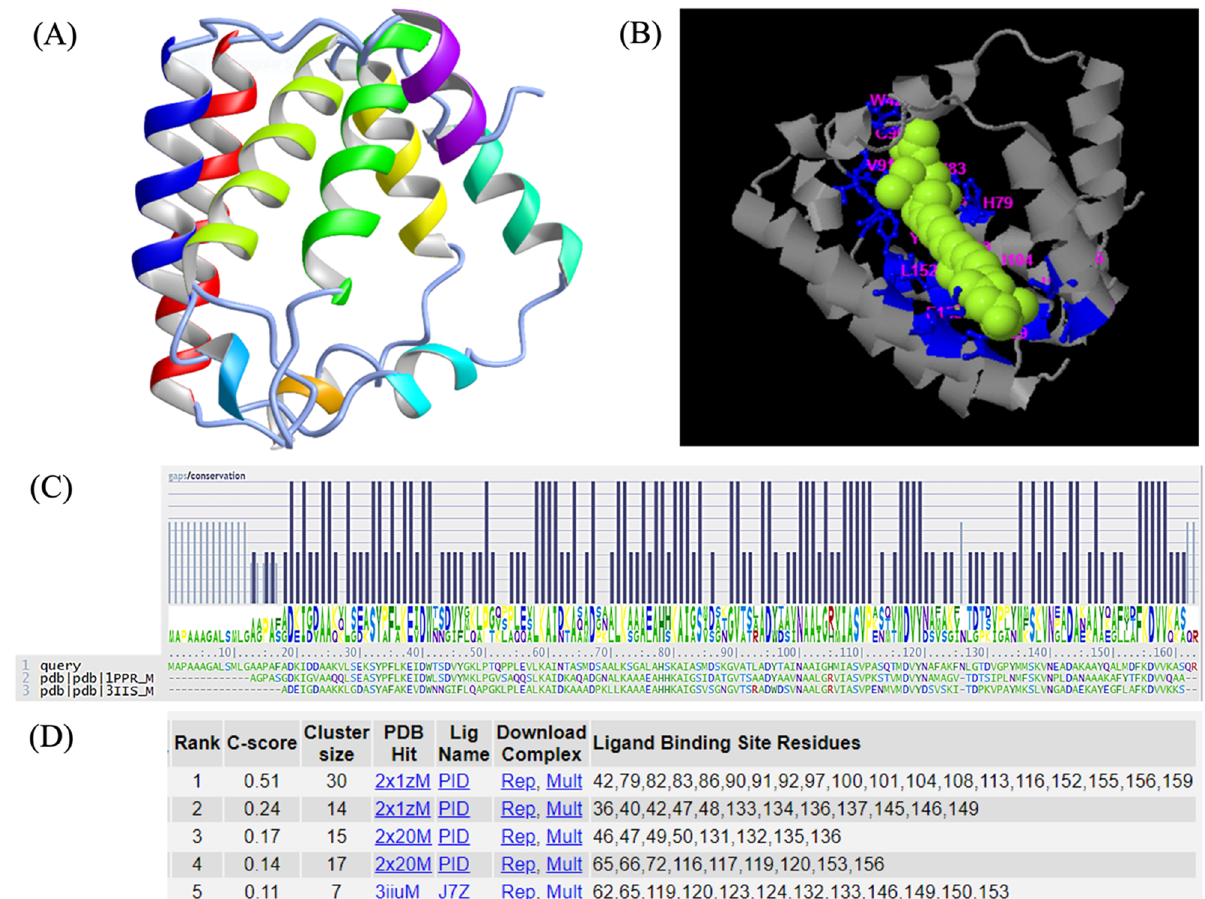
Figure 2. Secondary structure prediction of identified PCP protein sequence matched to accession SimA3.s6014_g3 ( A ), 3D model with ligand binding sites depicted by I-TASSER and COACH ( B ), I-TASSER-based PCP protein (from S. tridacnidorum ) sequence alignment to template IpprM with highest matching scores ( C ), ligand binding site residues prediction in PCP protein (from S. tridacnidorum ) sequence by COACH considering 1 pprM as a template model (https://www.rcsb.org/structure/1ppr, accessed on 26 January 2021) ( D ). PID denotes peridinin.